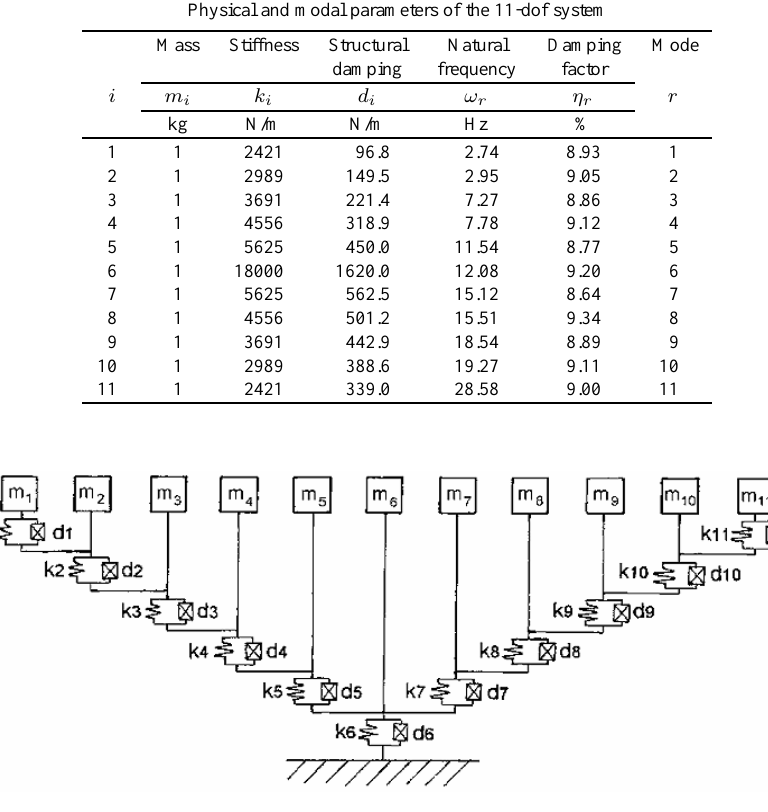
Fig. 12. 11-dof system with hysteretic damping.